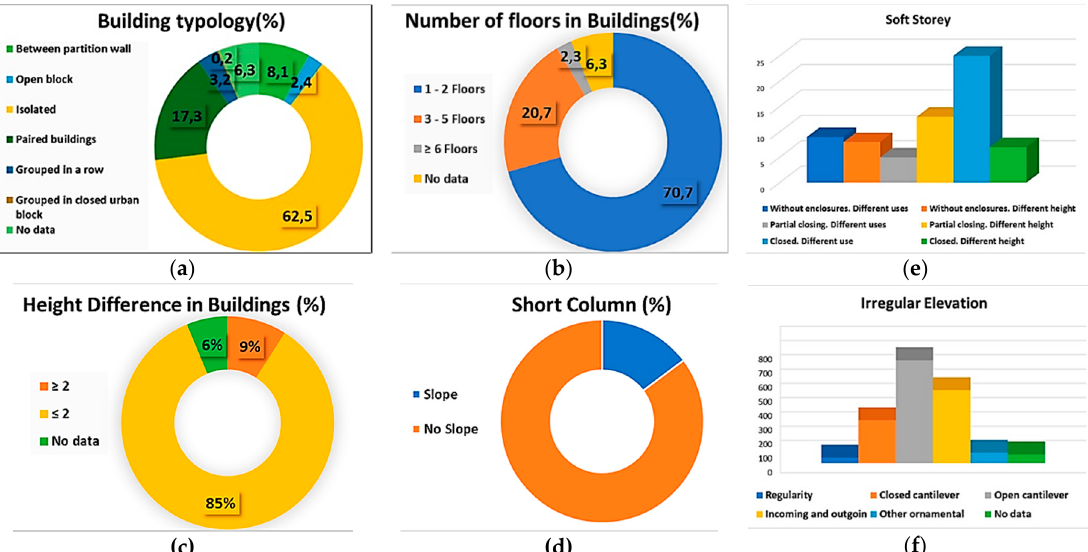
Figure 4. ( a ) Building typologies within the study area; ( b ) Building floors within the study area; ( c ) Height differences within study area; ( d ) Short column within the study area; ( e ) Soft storeys within study area; ( f ) Irregular elevation of buildings within the study area. Source: Own